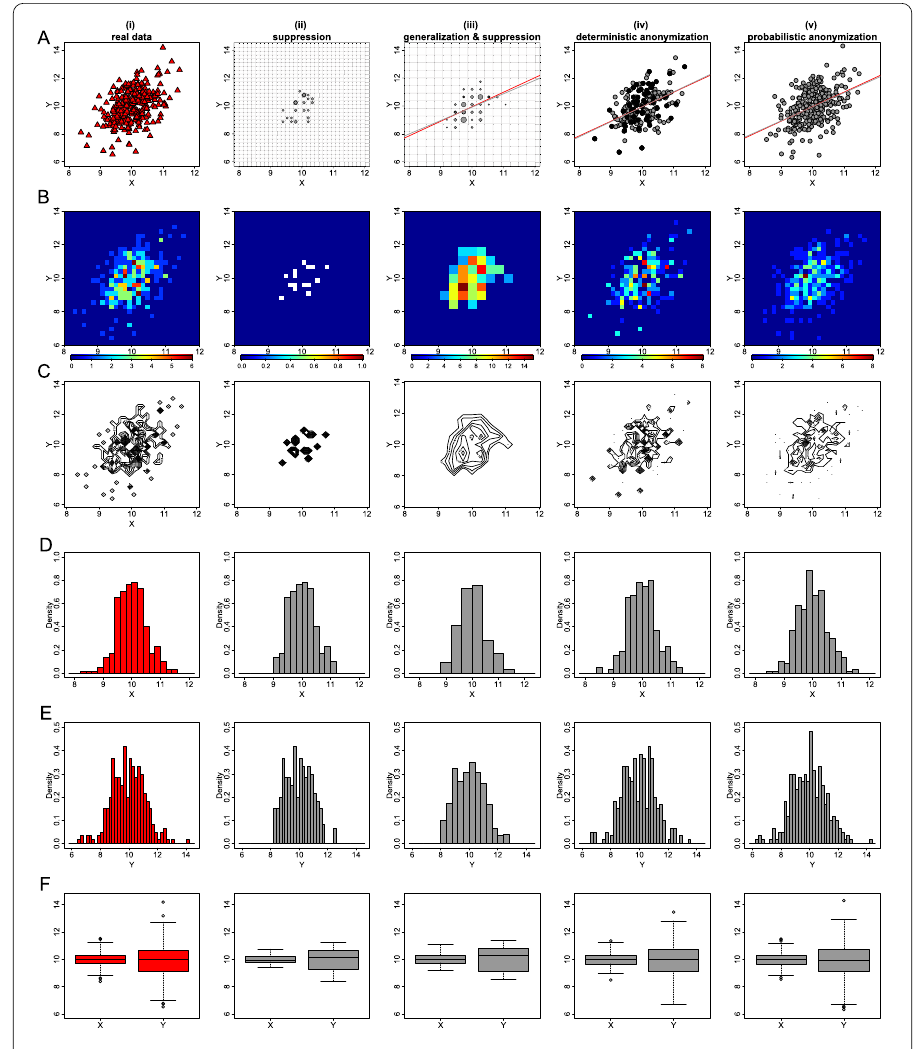
Figure 20 The performance of the techniques applied in a sample of 300 observations. From top to bottom we demonstrate the scatter plots ( A ), heat map plots ( B ), contour plots ( C ), histograms of X ( D ) and Y ( E ), and box plots ( F ) for real data (i), suppressed data (ii), generalized and suppressed data (iii), deterministically anonymized data (iv) and probabilistic anonymized data (v)